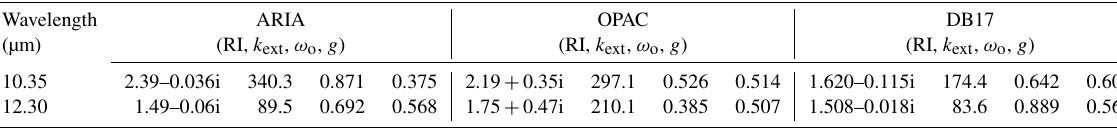
Table 1. Refractive indices (RI), mass extinction coefficient ( k ext ), single-scattering albedo ( ω o ), and asymmetry parameter ( g ) assumed for idealized SWBTD dust signal calculations with a dust effective radius of 2.4µm.